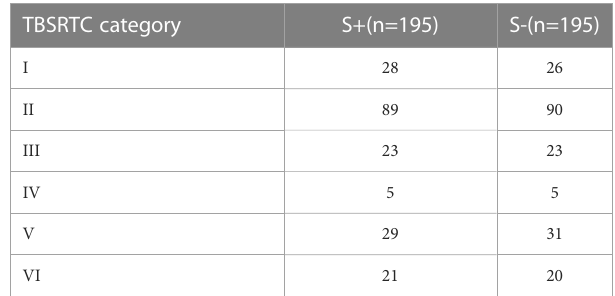
TABLE 1 Cytological results of specimens obtained with and without